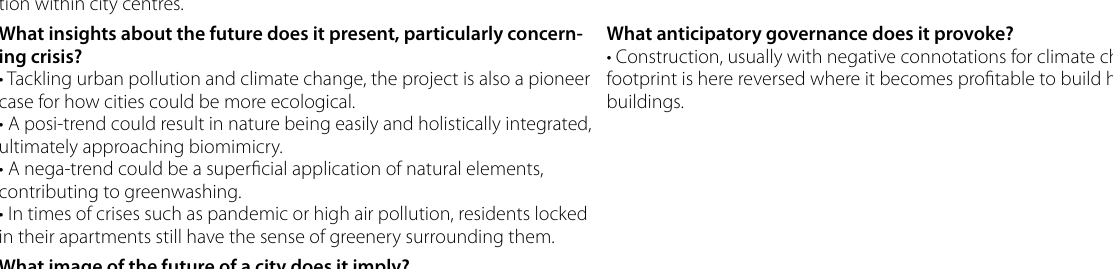
Table 3 Anticipatory analysis of Bosco Verticale How is it a hybrid space ? • A hybrid of technology and nature. Integrating nature as a component within the built building concept, with the added benefit of forest and vertical